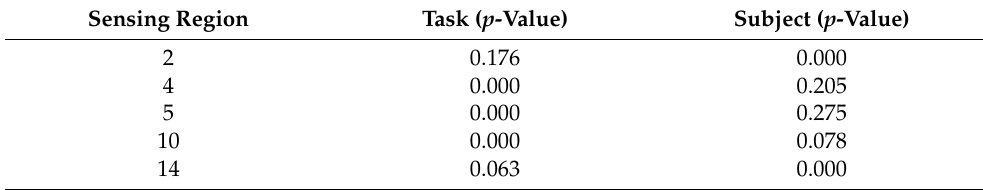
Table 5. Significance levels ( p -value) from the ANOVA tests on CGF with factors “subject” and “task” for regions showing non-significant effect from any of the two factors (significant effect with p < 0.05 for regions not